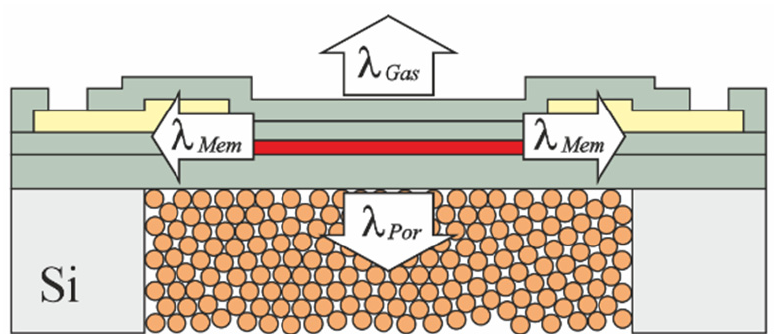
Figure 8. Simple 2D thermal model of the PowderMEMS-modified